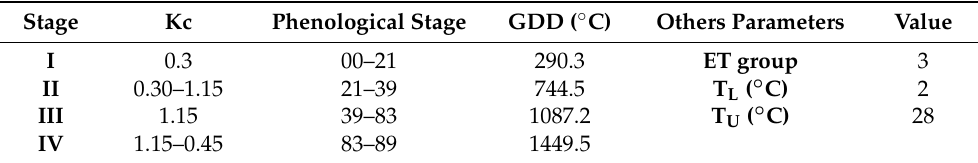
Table 3. Parameters required by MOPECO model to determine the irrigation scheduling of a barley crop under the climatic conditions in Castilla-La Mancha